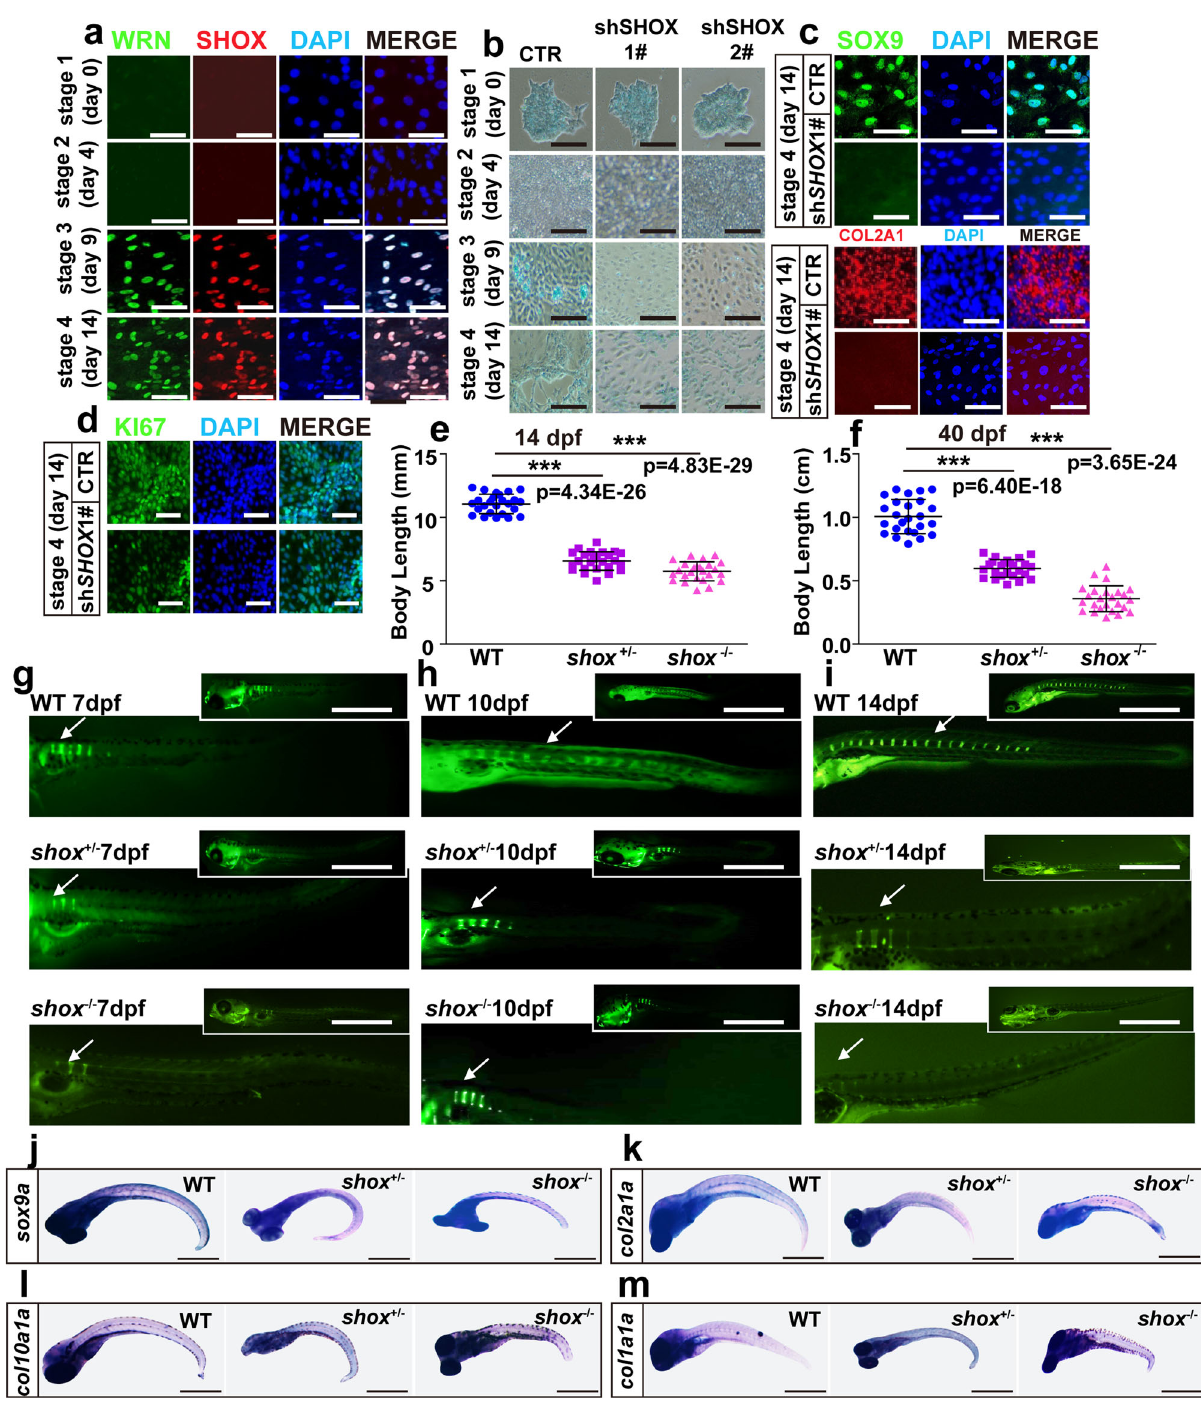
Fig. 6 | SHOX is a crucial regulator in WS bone development. a Representative immuno fl uorescentstainingof3independentexperimentsinCTR-hESCswithfour sequential time points. WRN and SHOX were examined. Scale bar=50 µ m. b Representative alcian blue staining of 3 independent experiments between CTR and two KD- SHOX groups. Scale bar=20 µ m. c Representative immuno fl uorescent stainingof3independentexperimentsbetweenCTRandshSHOX1#groupsonday 14inhESCs.SOX9andCOL2A1wereexamined.Scalebar=50 µ m. d Representative immuno fl uorescent staining of 3 independent experiments between CTR and shSHOX1# groups on day 14 in hESCs. Ki67 was examined. Scale bar=20 µ m. e , f Dot graph analysis of the total body length among WT, shox +/- , and shox − / −